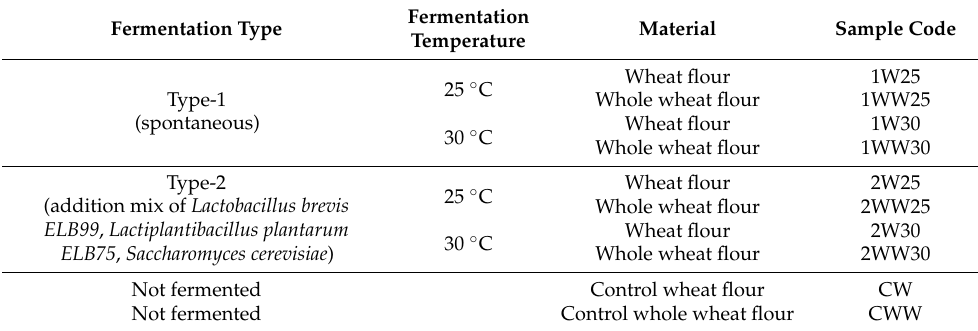
Table 1. Type-1 and type-2 fermentation conditions and sample